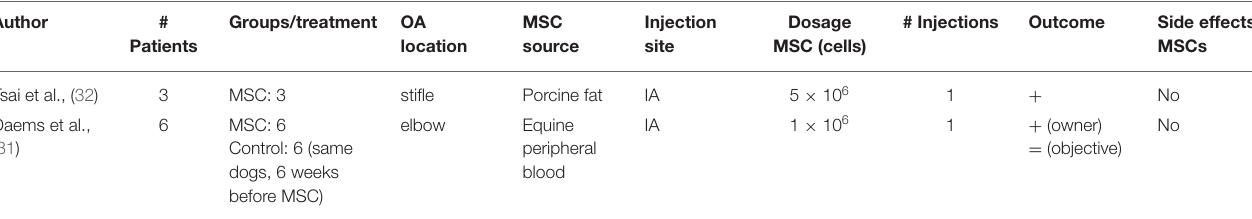
TABLE 3 | Chronologic presentation of studies on naturally occurring OA applying xenogeneic